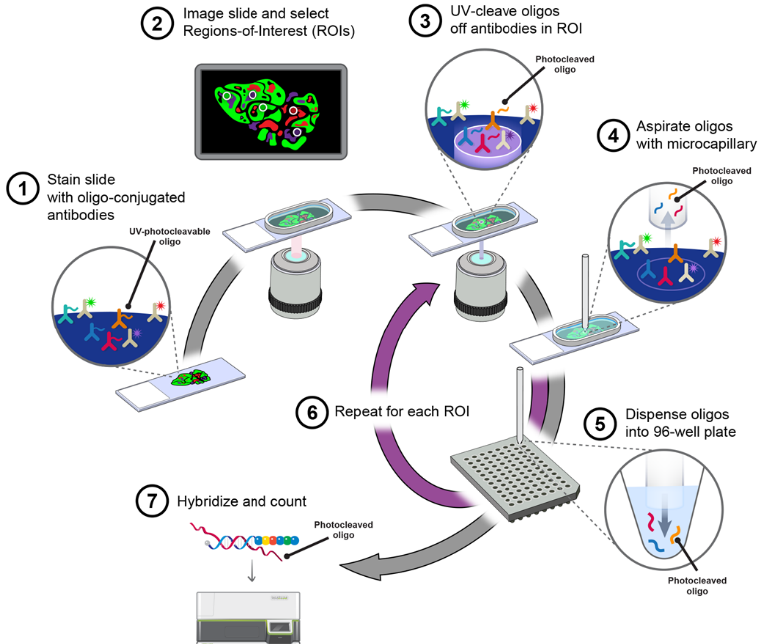
Figure 3. Schematic representation of the digital spatial profiling system (from NanoString documentation). Schematic representation of the digital spatial profiling